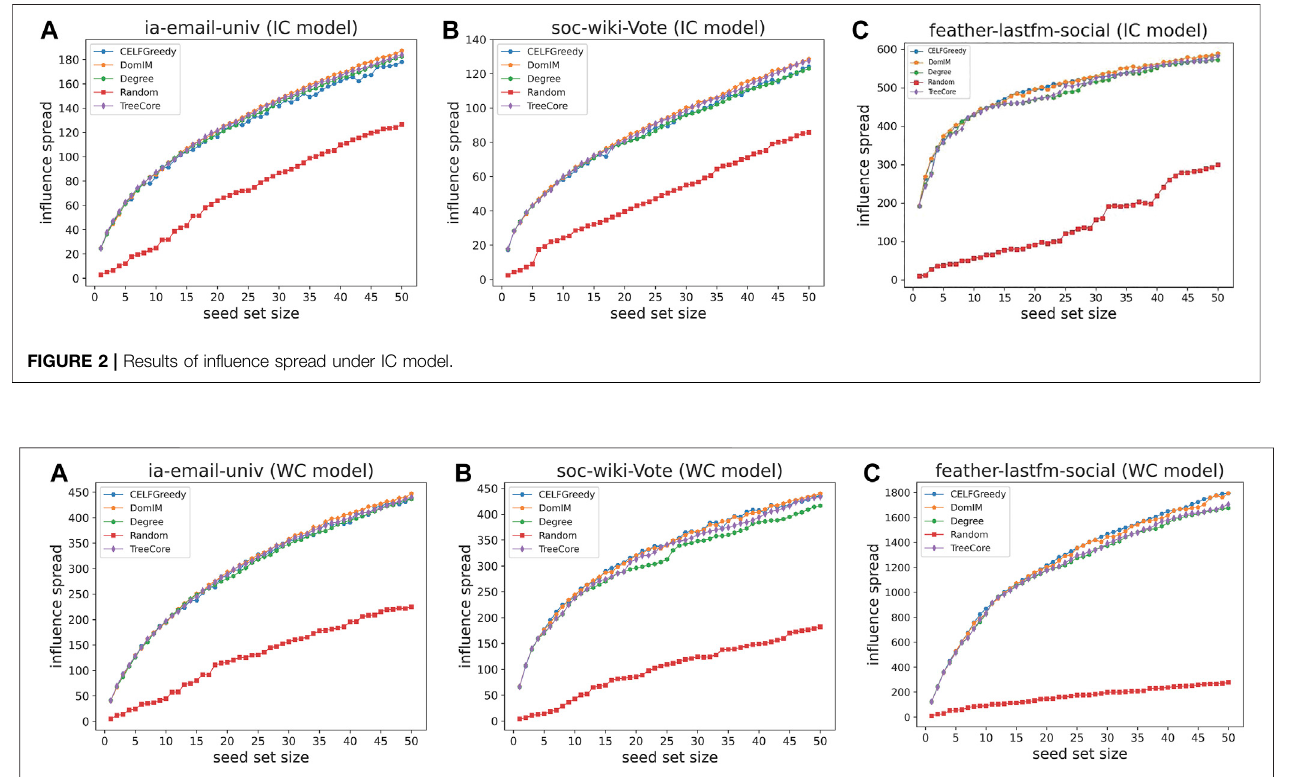
FIGURE 3 | Results of in fl uence spread under WC